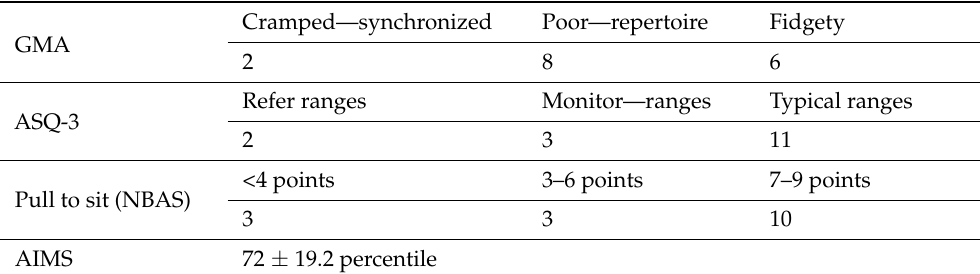
Table 2. Motor functioning of the participants. Cramped—synchronized Poor—repertoire Fidgety GMA